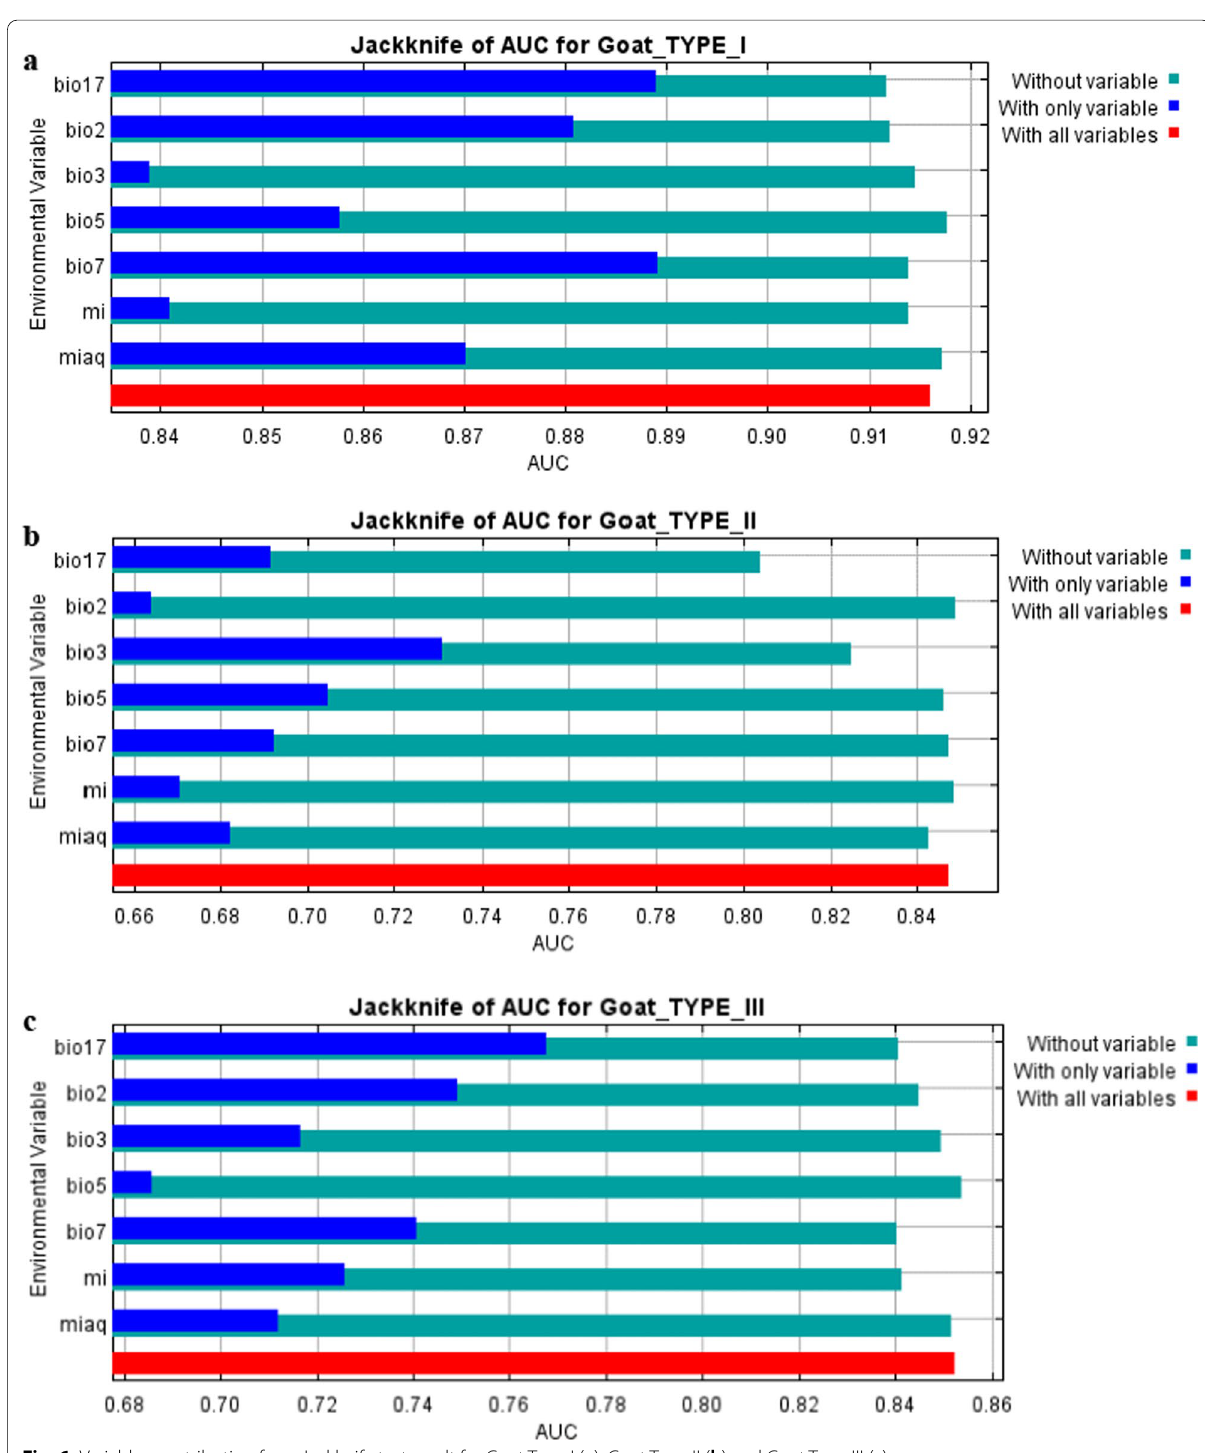
Fig. 6 Variables contribution from Jackknife test result for Goat Type I ( a ); Goat Type II ( b ) and Goat Type III ( c